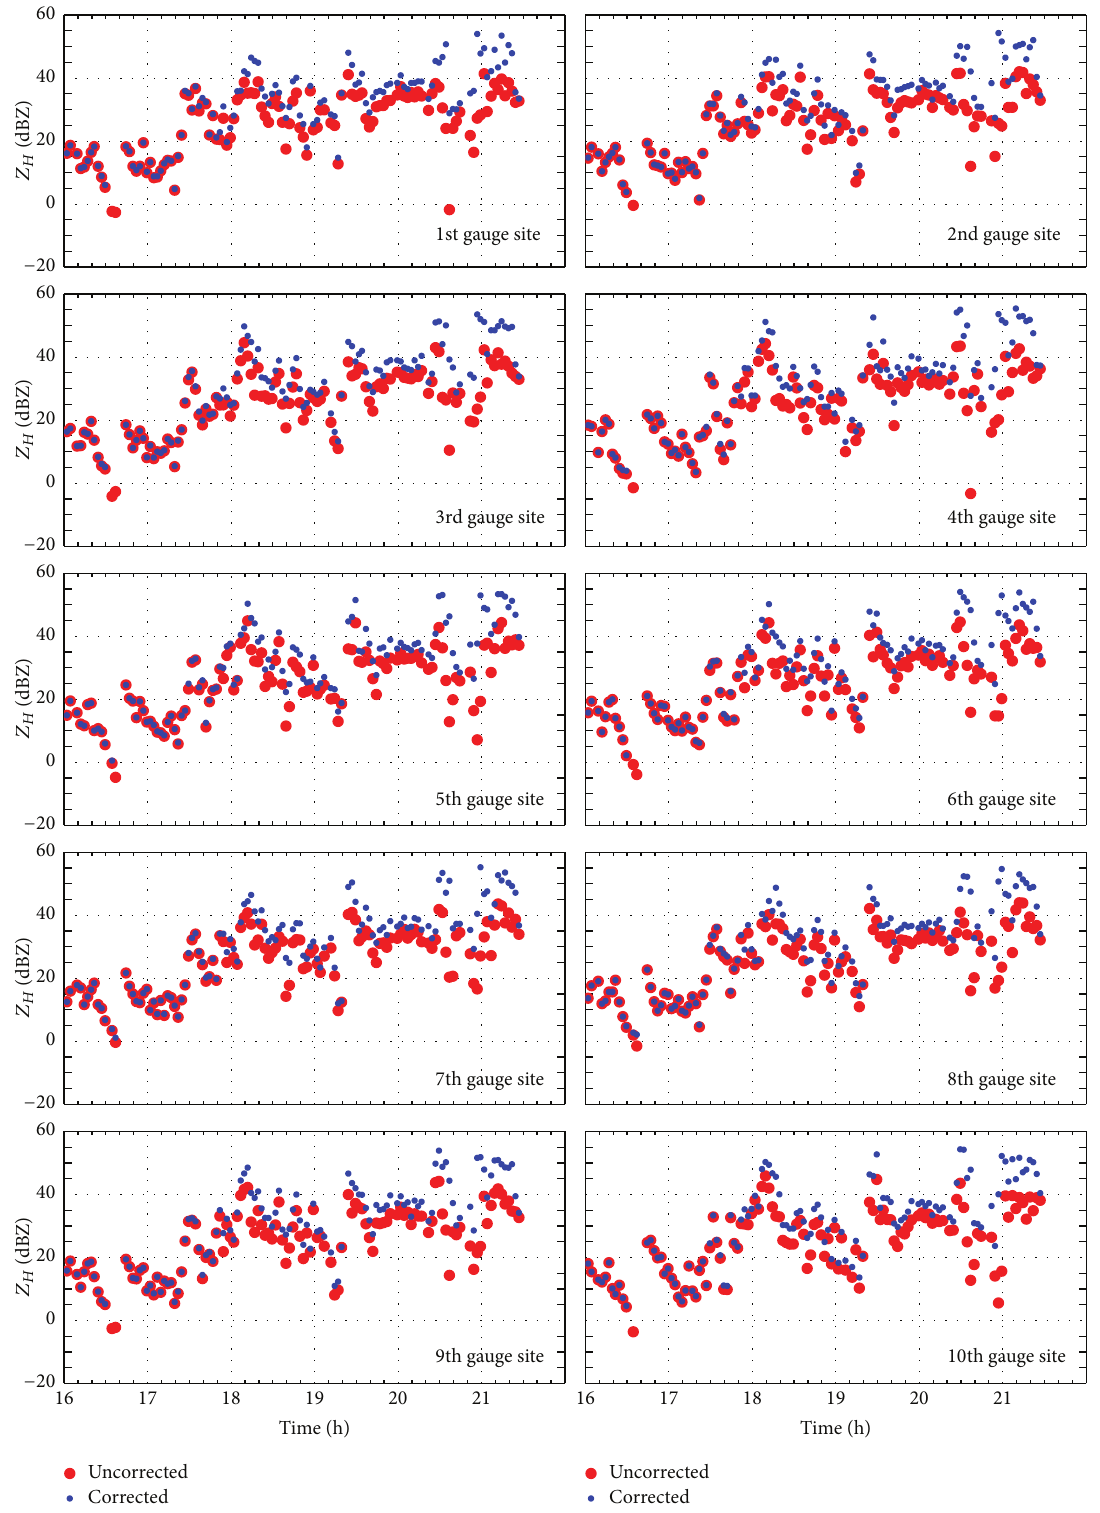
Figure 11: Time series of measured (red circle) and attenuation corrected (blue circle) 𝑍 𝐻 at the 10 rain gauge